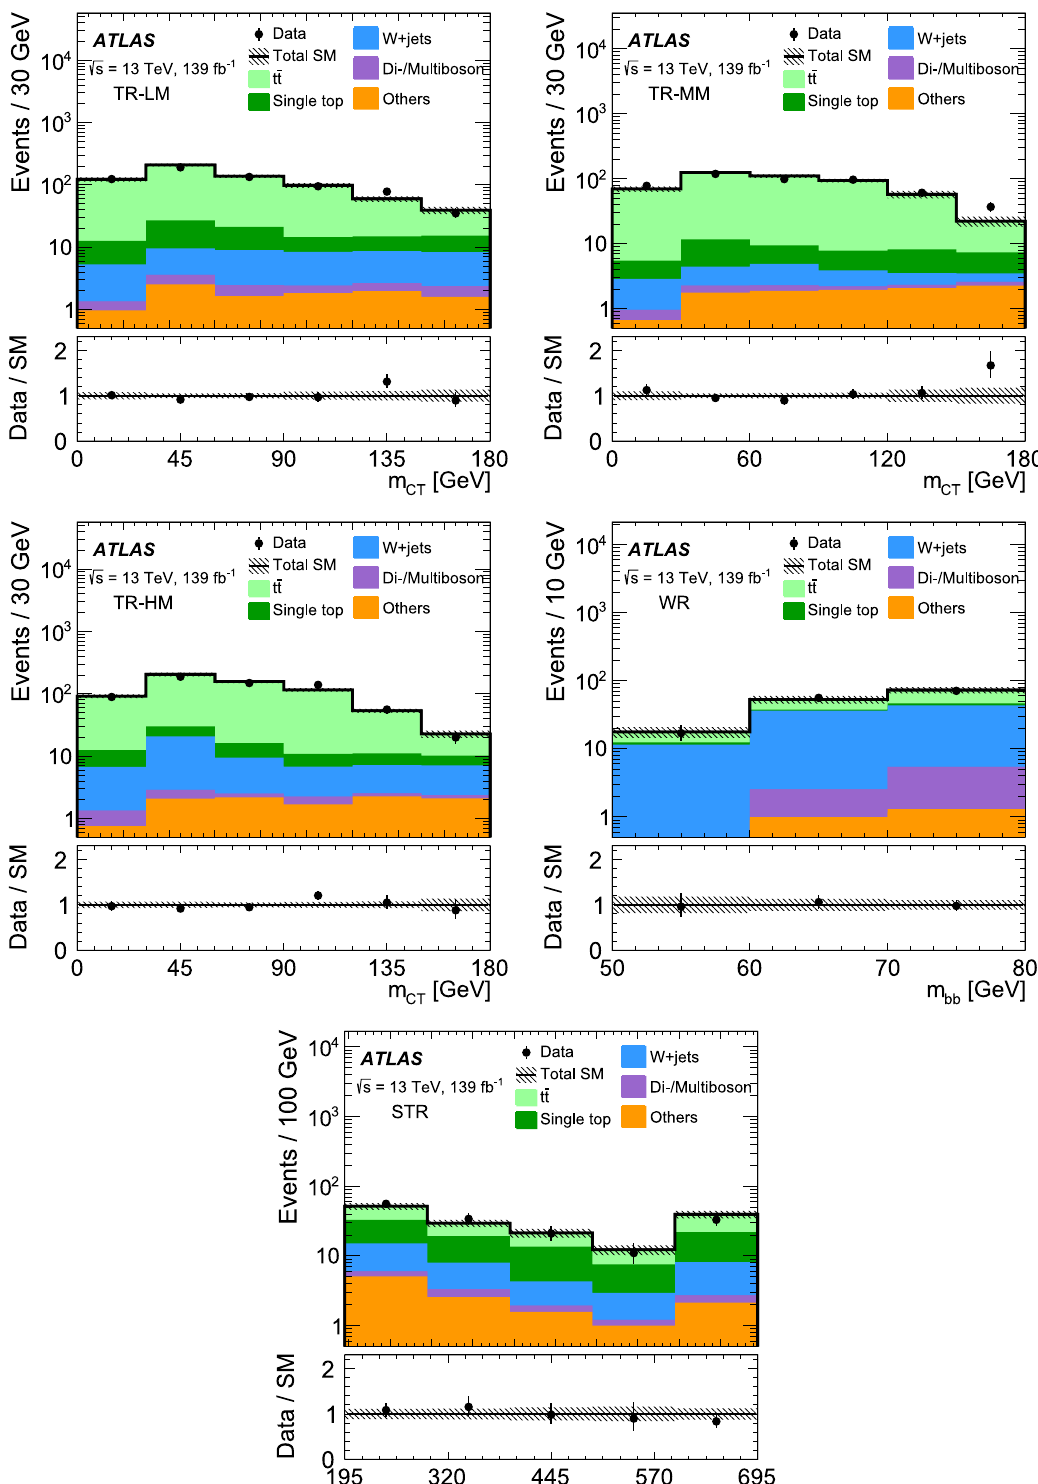
Fig. 2 The post-fit m CT distributions in TR-LM, TR-MM, and TR-HM are shown as well as the post-fit m uncertainty bands plotted include all statistical and systematic uncertainties. The overflow events, where present, are included in the last